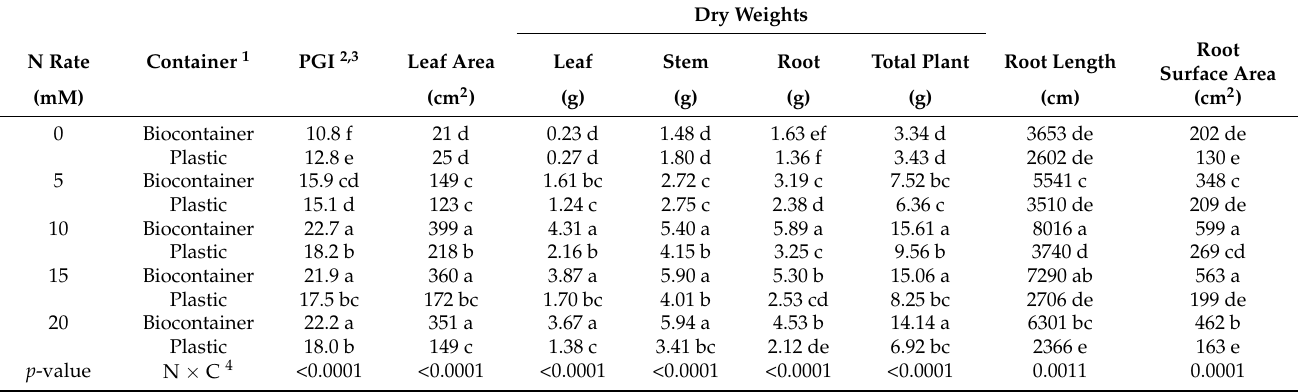
Table 1. Plant size, leaf area, dry weights, and root growth of Encore ® azalea ‘Chiffon’ affected by the N rate and container type